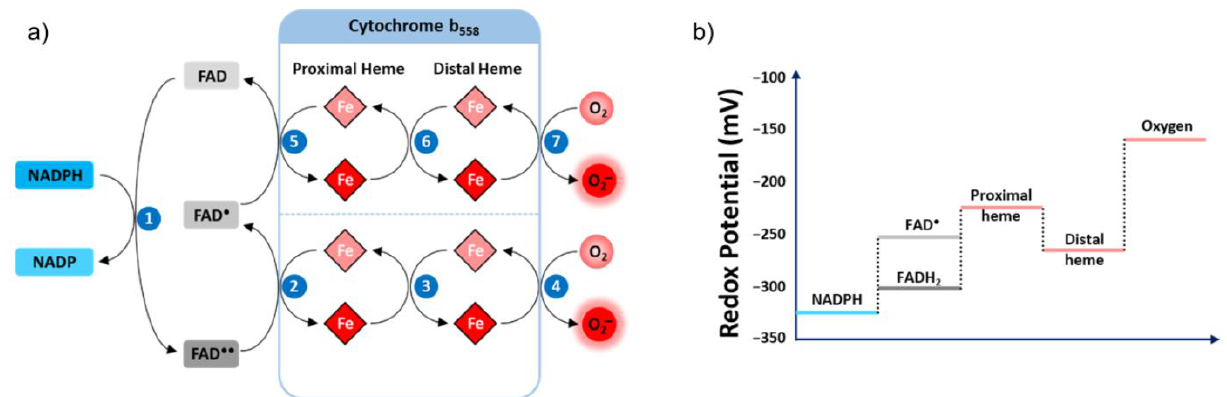
Figure 5. Mechanism of electron transfer catalyzed by the cytochrome b558 of NADPH oxidase. ( a ) The NADPH substrate provides two electrons that are transferred to the FAD, reducing it to FADH2. The FADH2 transfers a first electron to the proximal heme of the cytochrome, which is rapidly transmitted to the distal heme and then to molecular oxygen, forming superoxide. The second electron carried by the FAD cofactor is transferred in the same way with the FAD as an initial donor. The order of successive steps is indicated in blue circles. ( b ) Redox potentials of the different couples that participate in NOX-catalyzed electron transfer.